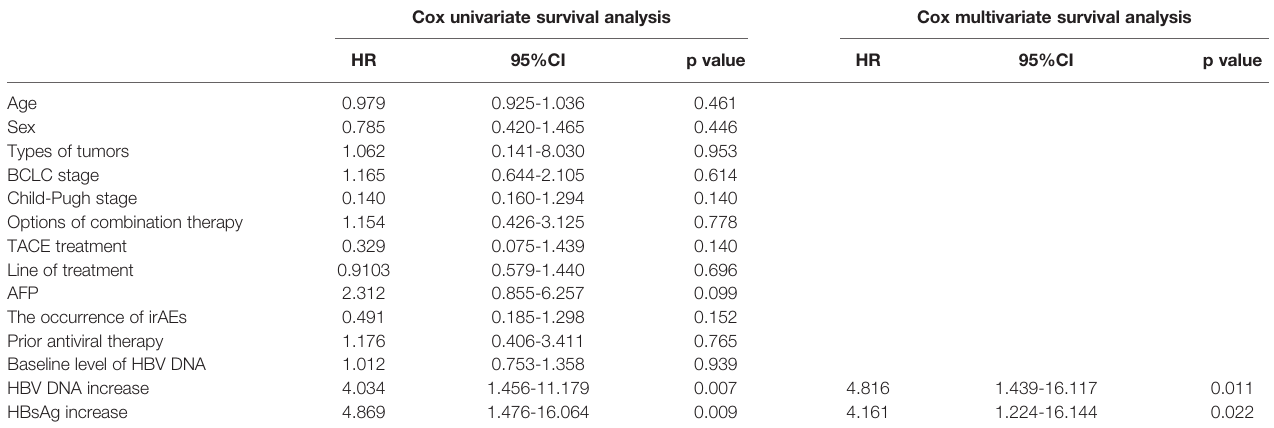
TABLE 4 | Cox univariate and multifactorial survival analysis to identify any independent predictive factor associated with